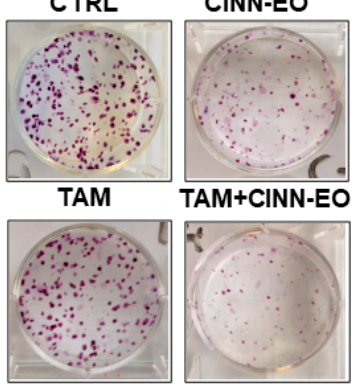
Figure 5. E ff ects of the combination of CINN-EO with the drug tamoxifen on M14 cell survival. ( A ) Colony formation assay on M14 cells exposed to CINN-EO alone or in combination with tamoxifen for 24 h. The cell survival percentages were calculated as the percentages of colonies formed in each sample versus the percentage of colonies formed in controls. ( B ) Images of the stained colonies obtained in each sample. ( C ) Expression of the indicated genes after CINN-EO ± TAM treatment. Relative fold-induction is calculated versus untreated M14 cells. * p < 0.05; *** p < 0.0001; § p < 0.0001.